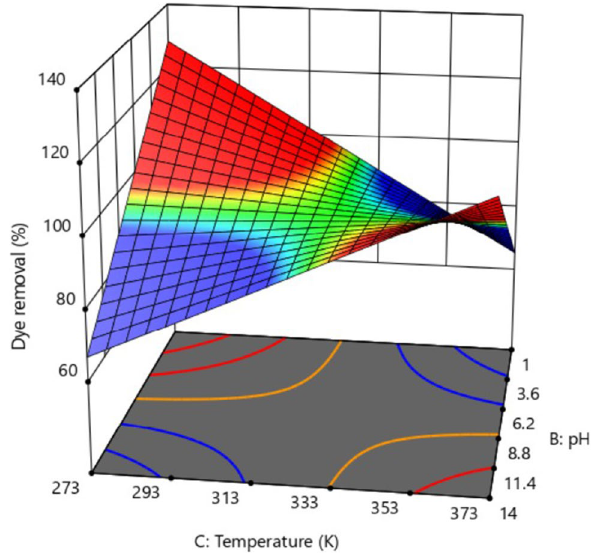
Fig. 20 Surface view showing the relation relative variation of per- centage dye removal with temperature and pH